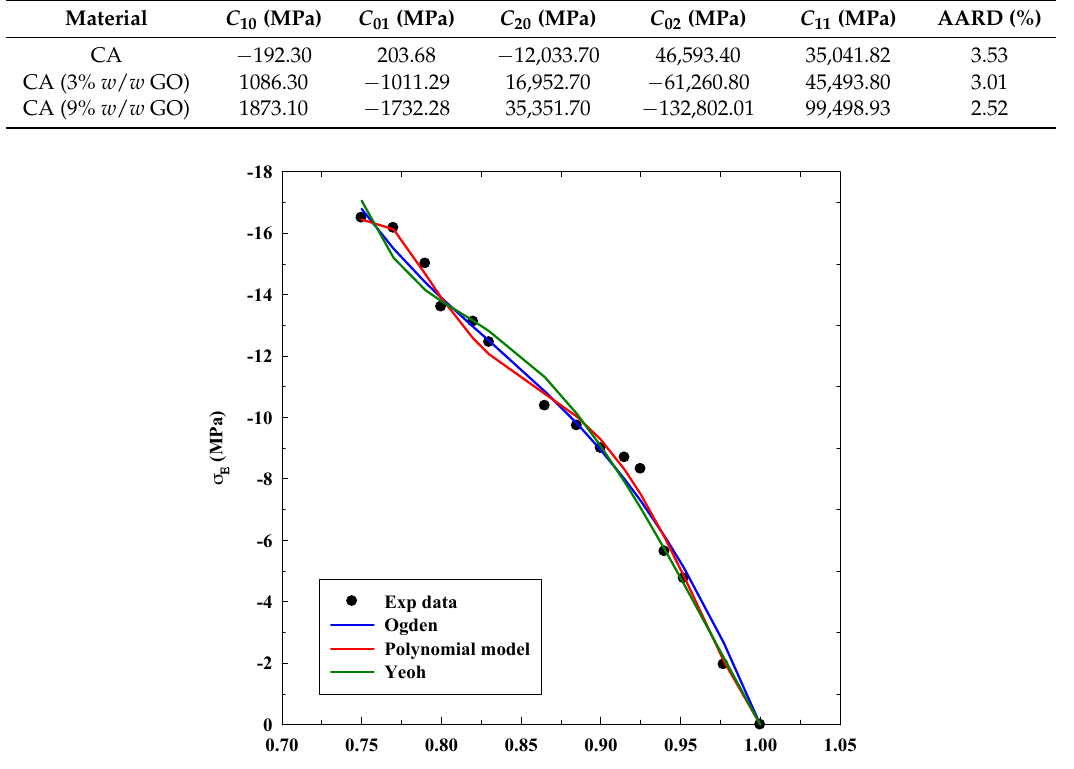
Figure 9. Fitting of compression tests for the system CA without GO using different models.